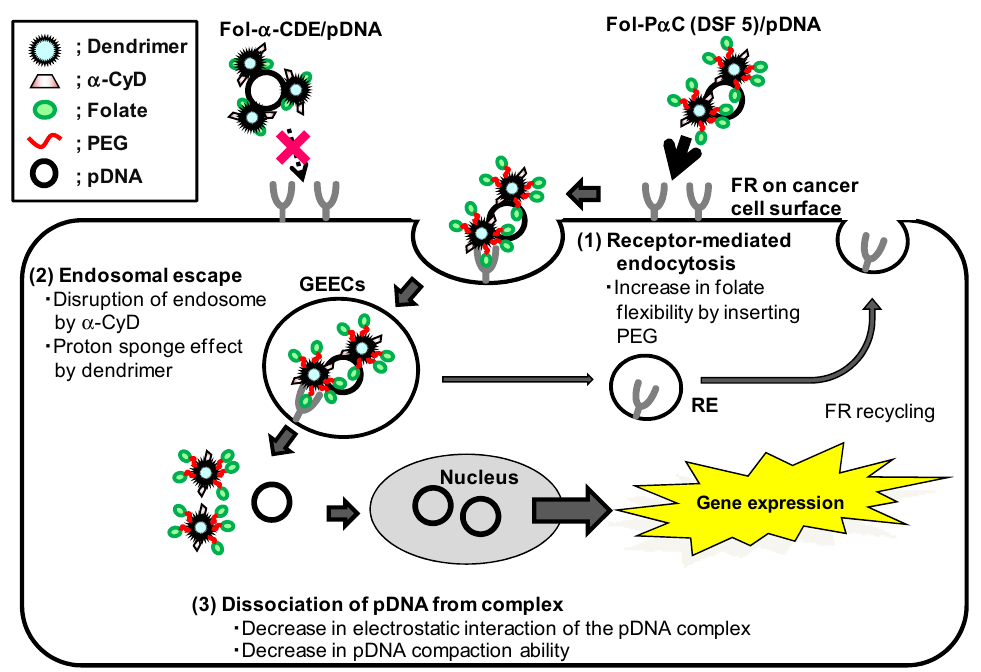
Figure 9. Proposed scheme for cancer cells-selective gene transfer activity of Fol-P α C (G3, DSF 5)/pDNA